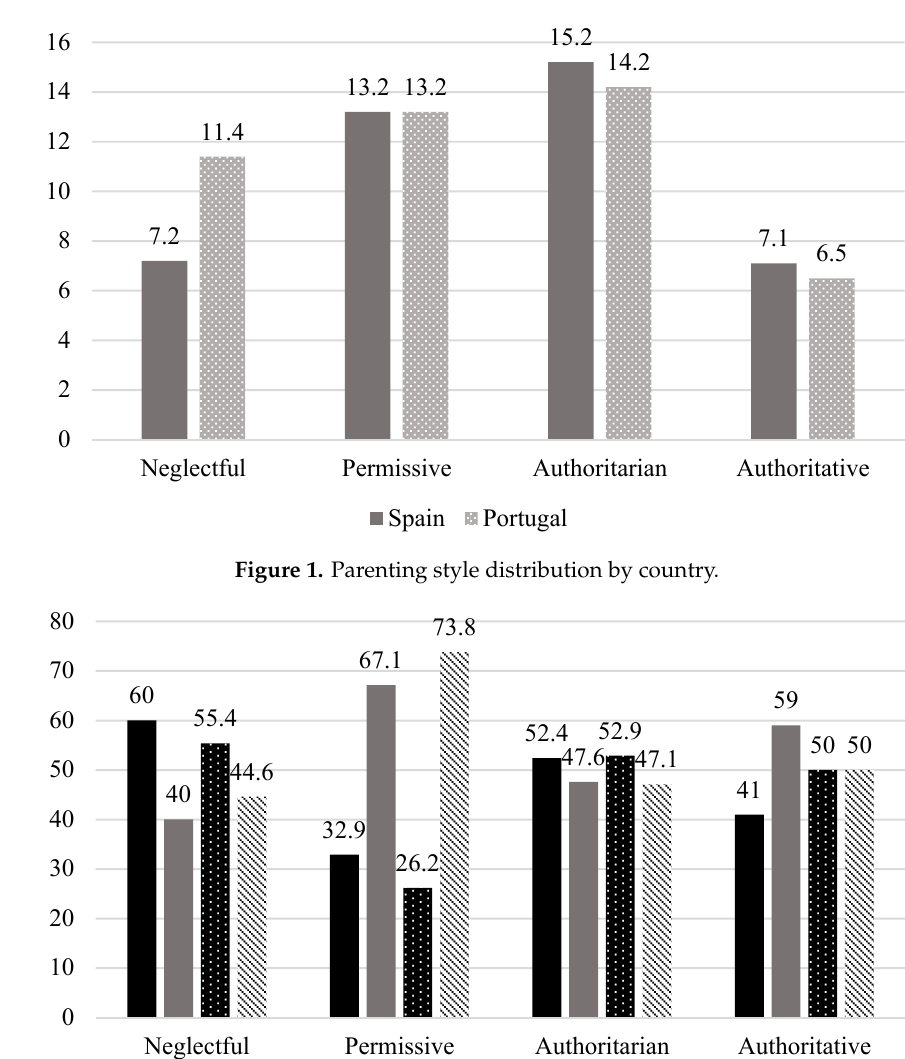
Figure 2. Sex distribution among each parenting style in Spain (SP) and Portugal (PT).